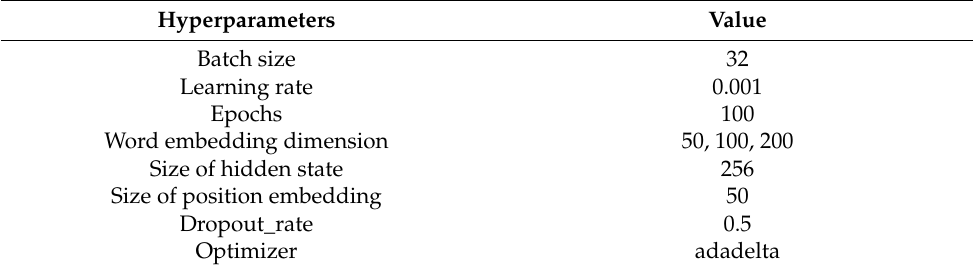
Table 6. The model parameters.